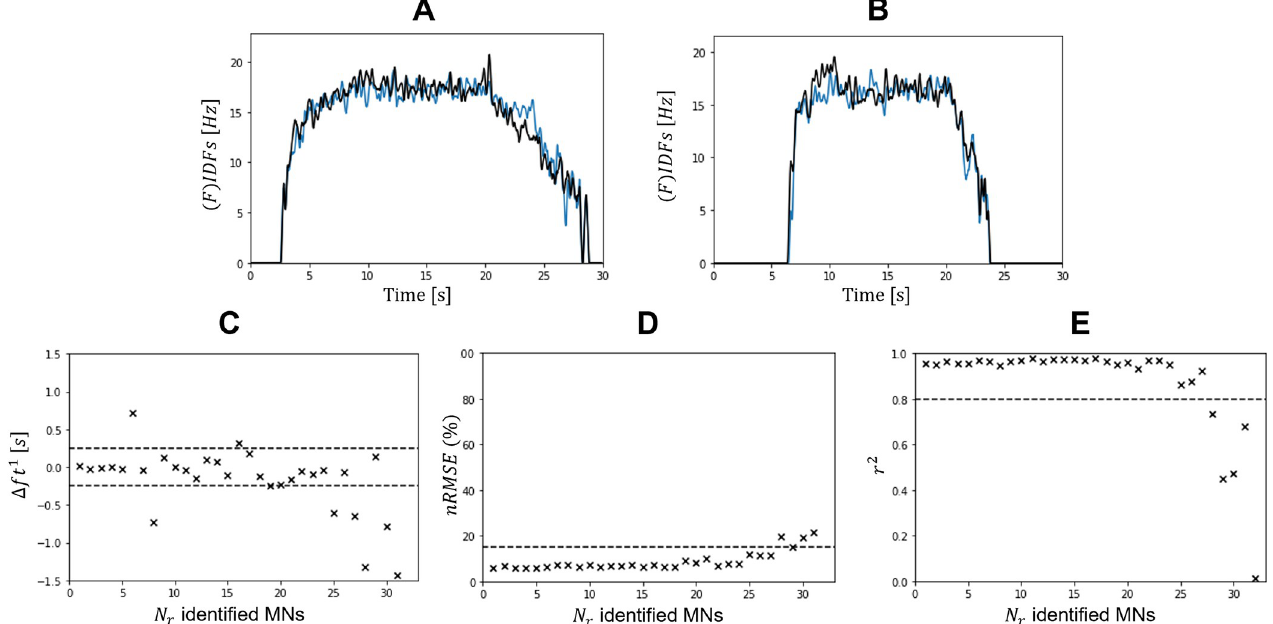
Fig 9. Calibration of the MN size S i parameter. (A and B) Time-histories of the experimental (black) versus LIF-predicted (blue) filtered instantaneous discharge frequencies (FIDFs) of the 2 nt (A) and 16 th (B) MNs identified in the DTA 35 dataset after parameter calibration. (C) Absolute error Δ ft 1 in seconds in predicting the MN recruitment time with the calibrated LIF models. The accuracy of LIF-predicted FIDFs is assessed for each MN with calculation of the nRMSE (D) and r 2 (E) values. (C-E) The metrics are computed for the ½ t ; t � time range only. The dashed lines represent the Δ ft 1 2 [ − 250; 250] ms , nRMSE 2 [0; r 0 r 3 15]% MVC and r 2 2 [0.8, 1.0] intervals of interest respectively.